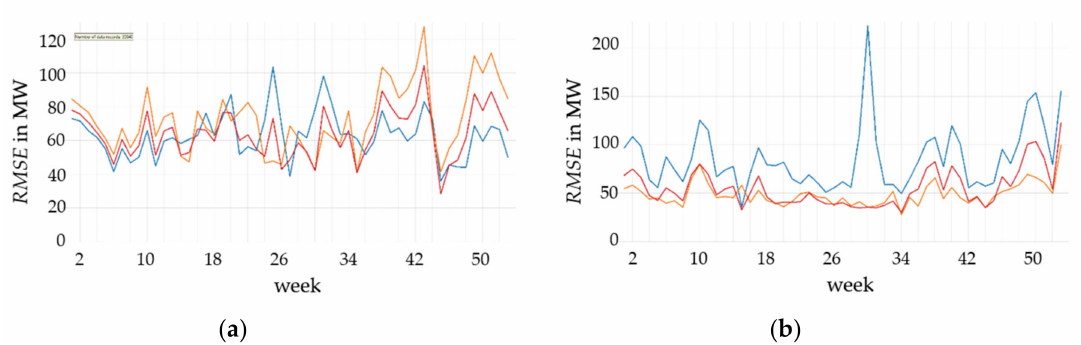
Figure 7. Error development of the total load forecast in 2019 for ( a ) Neuenhagen and ( b ) Wolmirstedt: load forecasts using neural networks (blue), the regression algorithm (orange), and a static combination of both